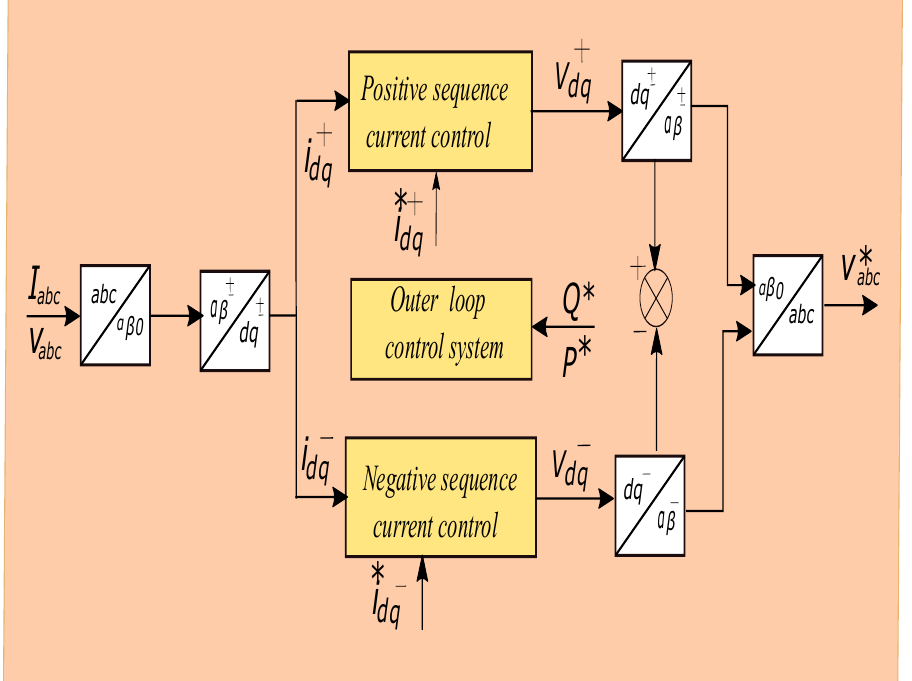
Figure 9. Control